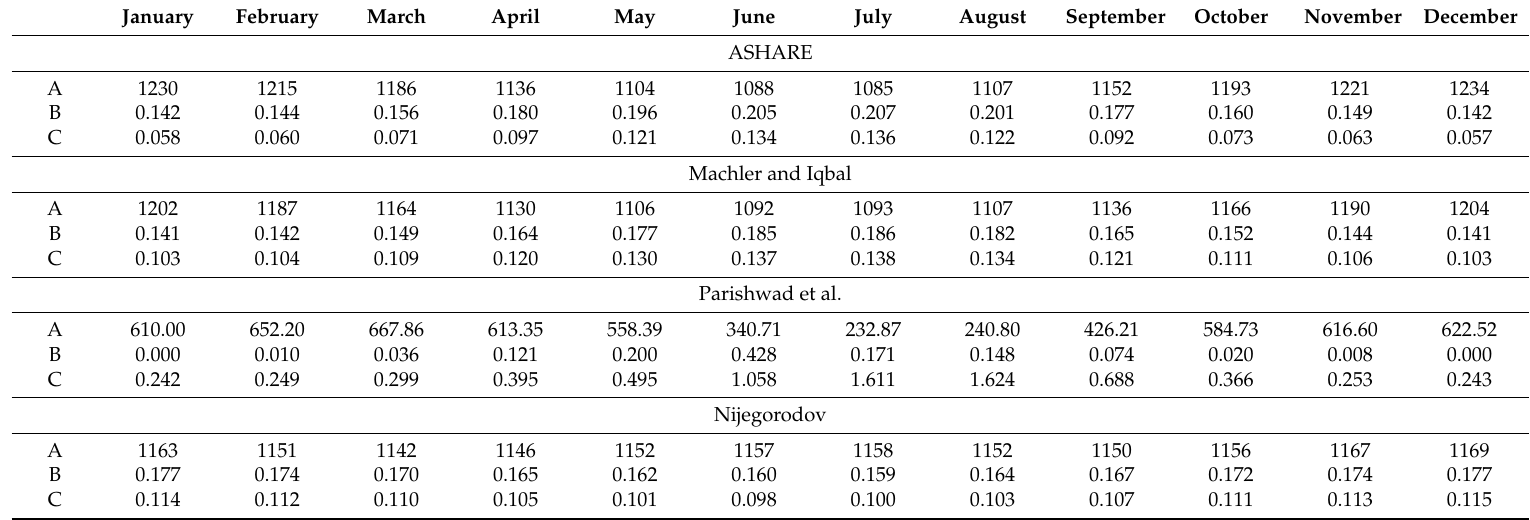
Table 1. Estimated values of A, B, and C for different